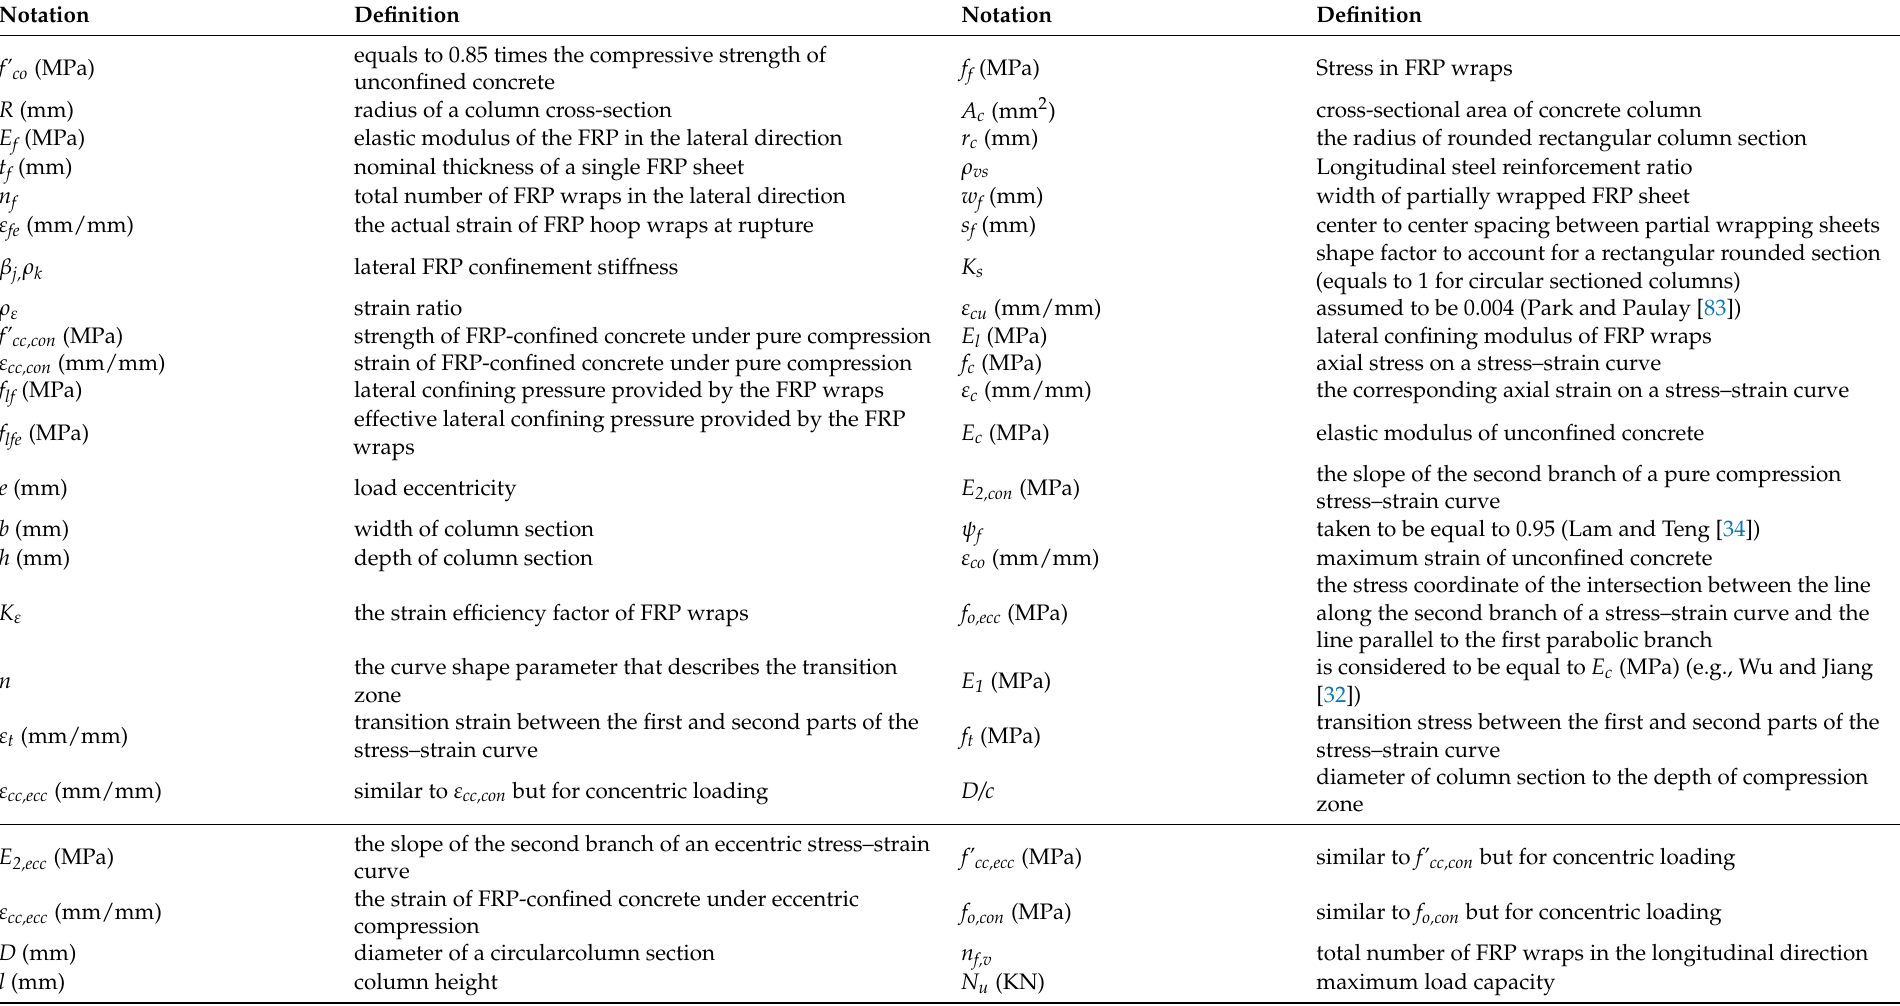
Table A4. List of